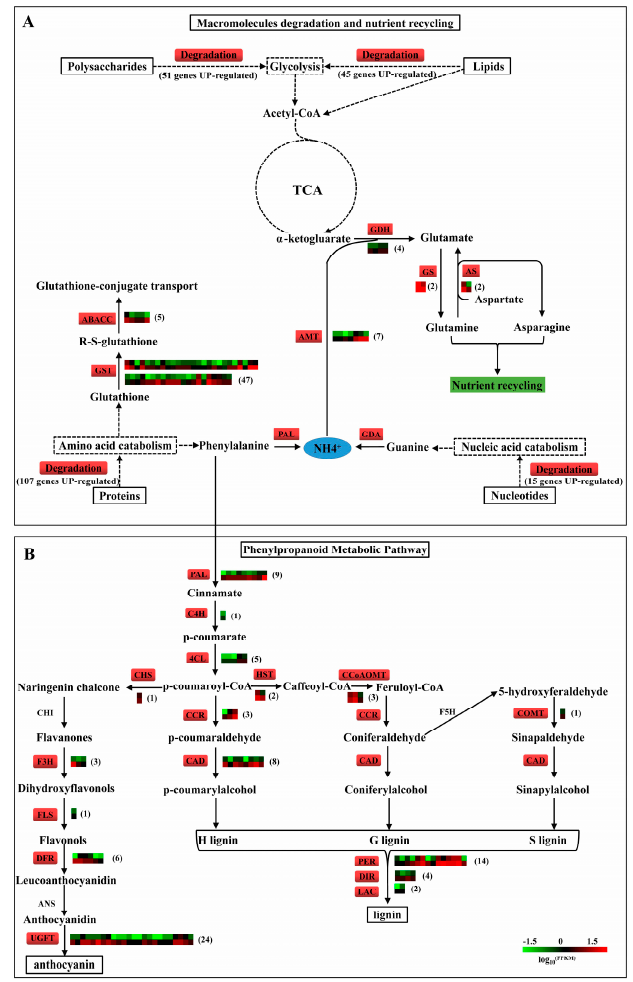
Figure 8. The key metabolic pathway and regulatory network in mutant ptsd1 . ( A ) Macromolecule degradation and nutrient recycling in mutant ptsd1 . ( B ) Overview of putative phenylpropanoid metabolic pathway involved in anthocyanin and lignin biosynthesis in ptsd1 . TCA, tricarboxylic acid cycle; the box includes the critical enzymes comprising the entry pathway. Enzymes coloured in red indicate the highly expressed genes in ptsd1 -YS, the heatmaps show the expression profiles between WT-YS (upside) and ptsd1 -YS (downside), the figures in the parentheses are the numbers of DEGs. The real lines indicate the direct products, the dotted lines indicate the indirect products and metabolic process. ABCC3, ABC transporter C; GST, glutathione S-transferase; AMT, ammonium transporter; GDA, guanine deaminase; GDH, glutamate decarboxylase; GS, glutamine synthetase; AS, asparagine synthetase; PAL, phenylalanine ammonia-lyase; C4H, cinnamate 4-monooxygenase; 4CL, 4-coumarate-CoA ligase; CHS, chalcone synthase; CHI, chalcone isomerase; F3H, naringenin, 2-oxoglutarate 3-dioxygenase; FLS, flavonol synthase; DFR, dihydroflavonol-4-reductase; ANS, anthocyanidin synthase; UFGT, anthocyanidin 5,3- O -glucosyltransferase; HST, shikimate O-hydroxycinnamoyl- transferase; CCR, cinnamoyl CoA reductase; CAD, cinnamyl alcohol dehydrogenase; CCoAOMT, caffeoyl-CoAO-methyltransferase; COMT, tricetin 3,4,5apos- O - trimethyltransferase; PER, peroxidase; DIR, dirigent protein; LAC, laccase. The detailed information of the DEGs is listed in Table S19,20.